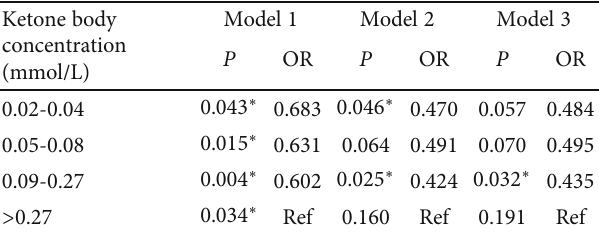
Model 1: unadjusted; Model 2: adjustment for sex, age, duration, SBP, DBP, HR, TC, TG, LDL, HbA1c, BUN, ALB, and BMI; Model 3: Model 2 +additional adjustment for consumption of tobacco and alcohol. ∗ P < 0 : 05